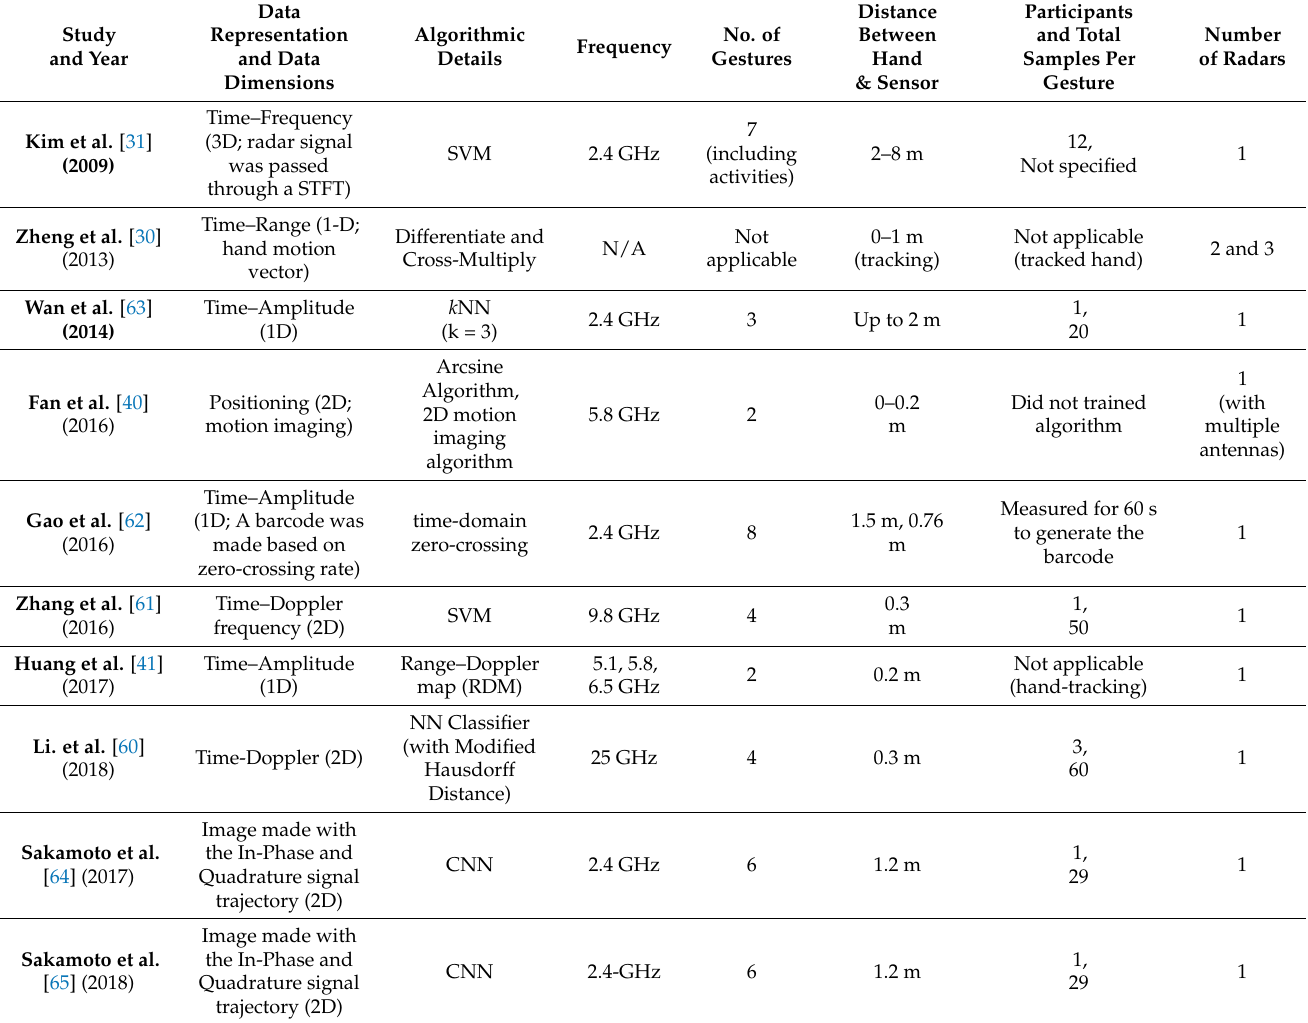
Table 4. Summary of HGR algorithms for SFCW (Doppler)